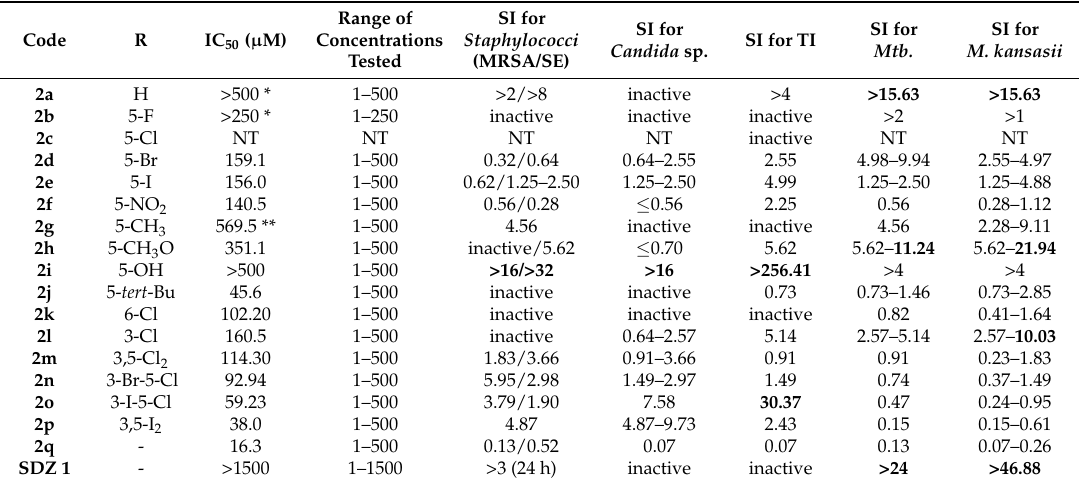
Table 5. Cytotoxicity for HepG2 cells and